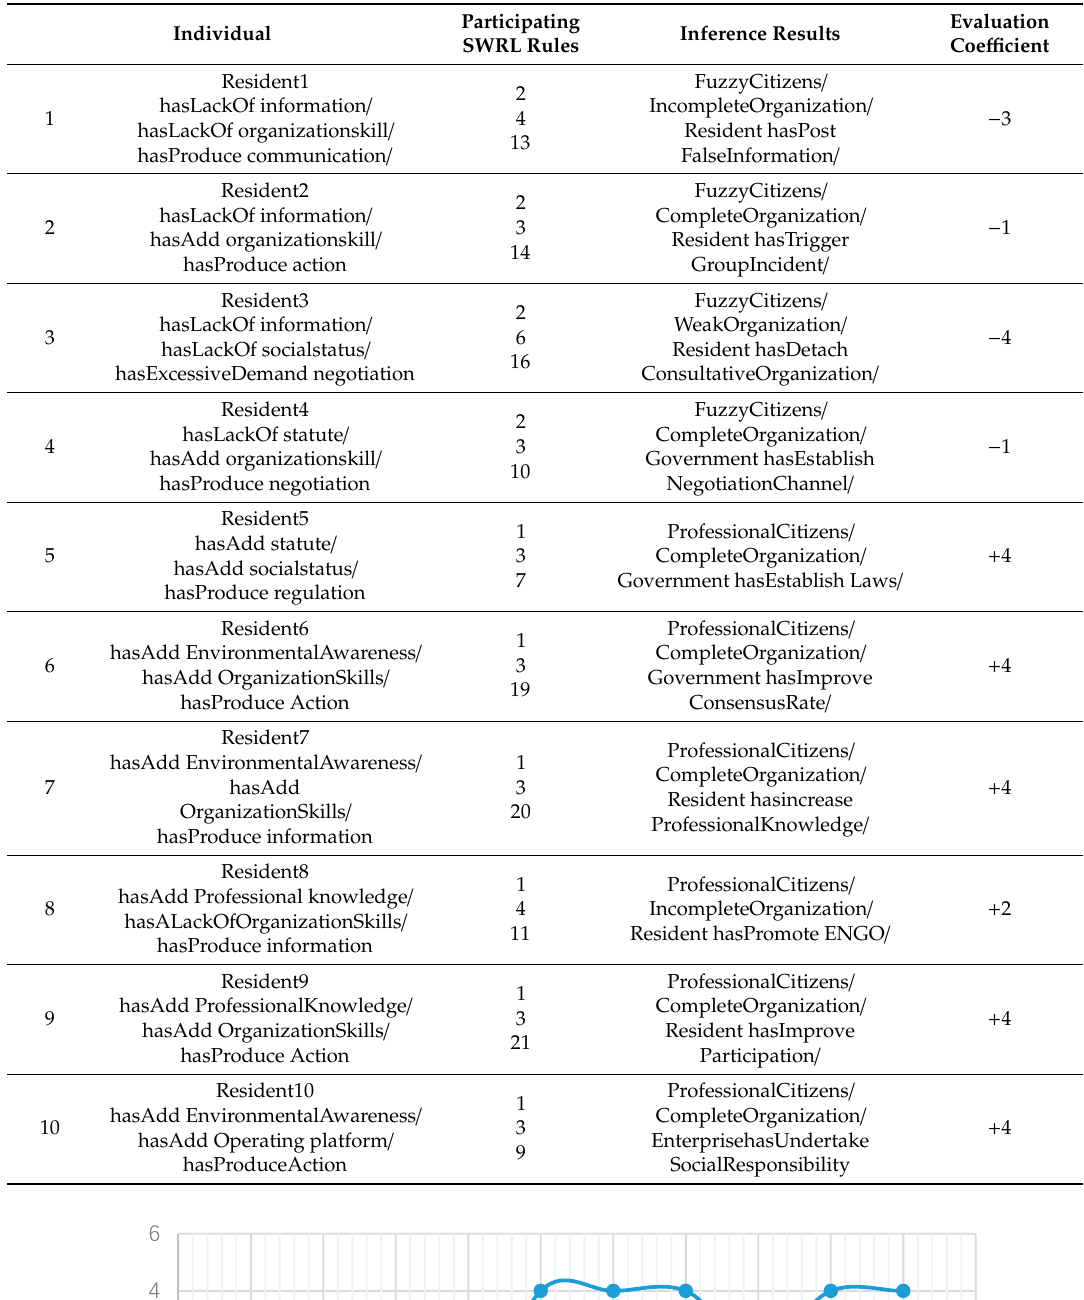
Table 4. The inference result of individual in the case in Z city.